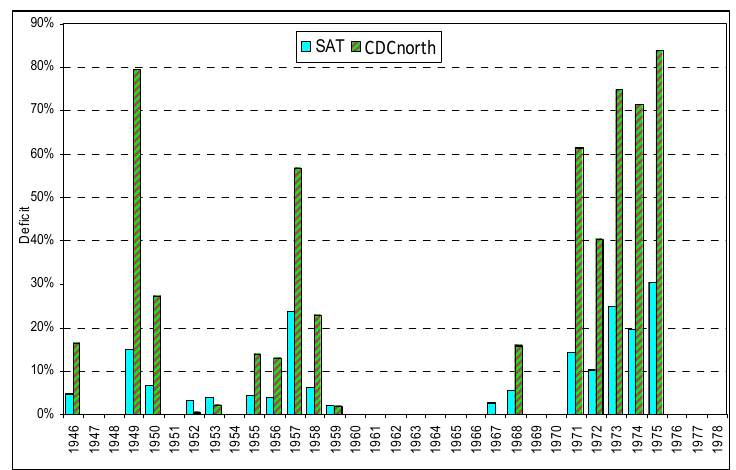
Figure 5. Deficit SAT (municipal) and CDC north (irrigation), in scenario n.1.